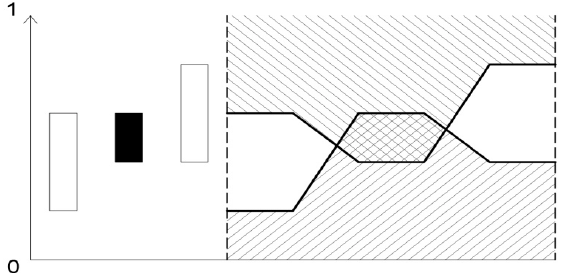
Figure 11. A sequence of candlesticks and the corresponding LBIFS.